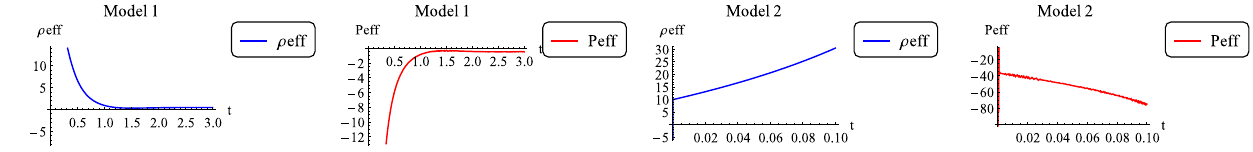
Fig. 4 The energy density, ρ ef f , and pressure, p ef f , in terms of cosmic-time under different viable models